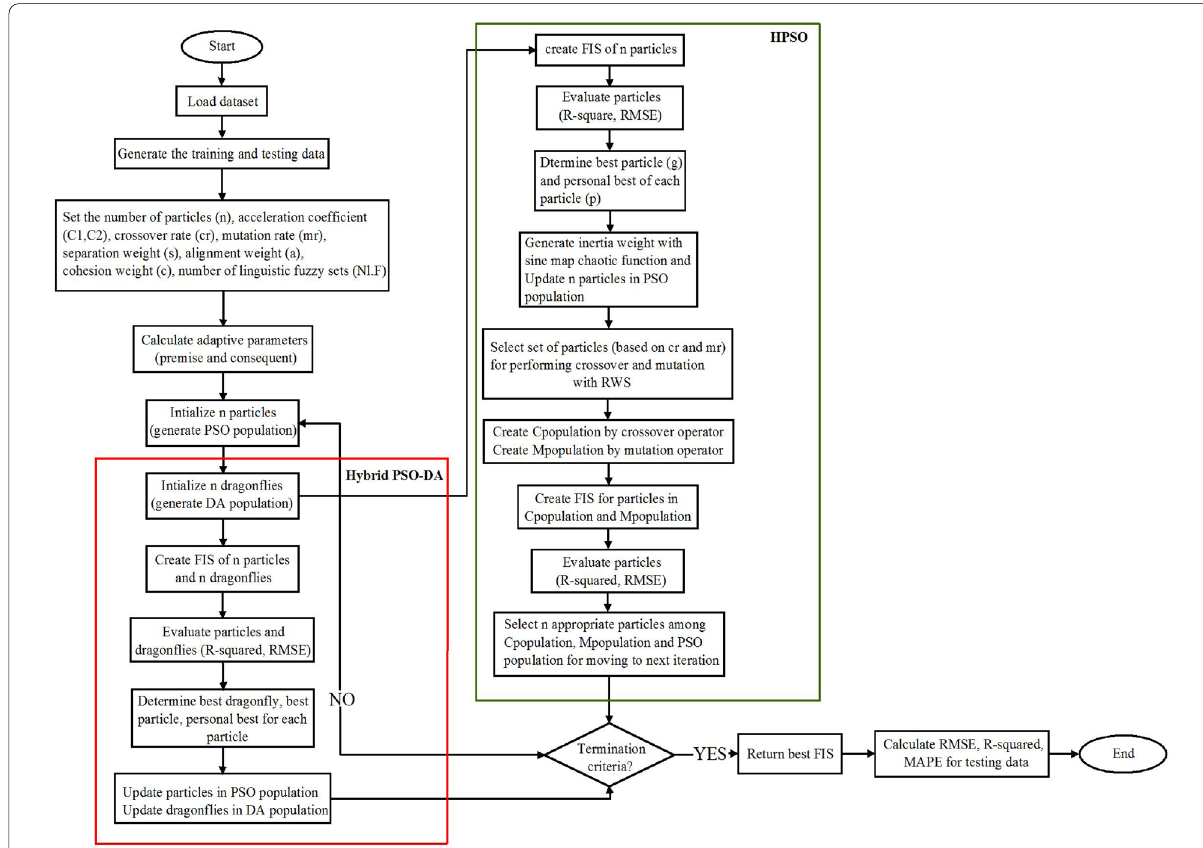
Fig. 5 PSO-based ANFIS